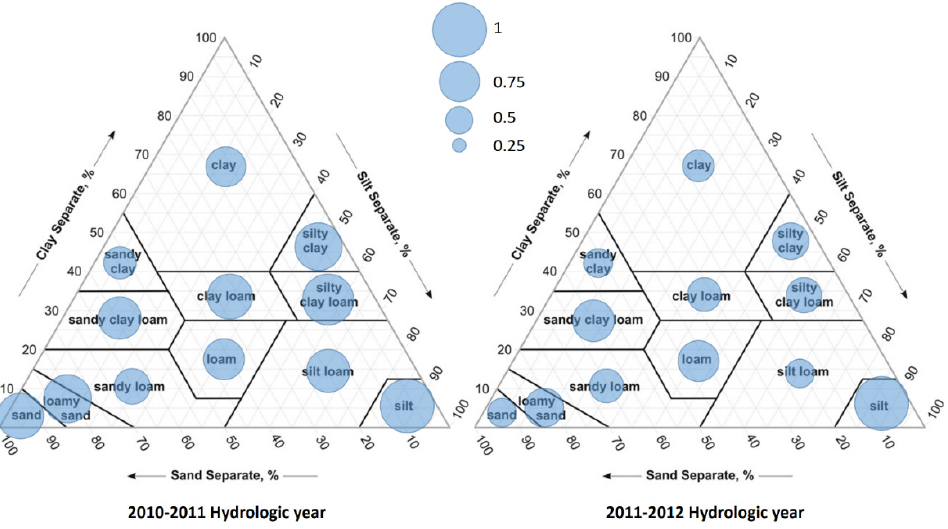
Figure 4. Maximum ice content, 2010–2011 and 2011–2012 hydrologic years. Results were normalized ranging from 0 to 1; each circle represents the scaled result. A bigger circle indicates the highest value in the metric.